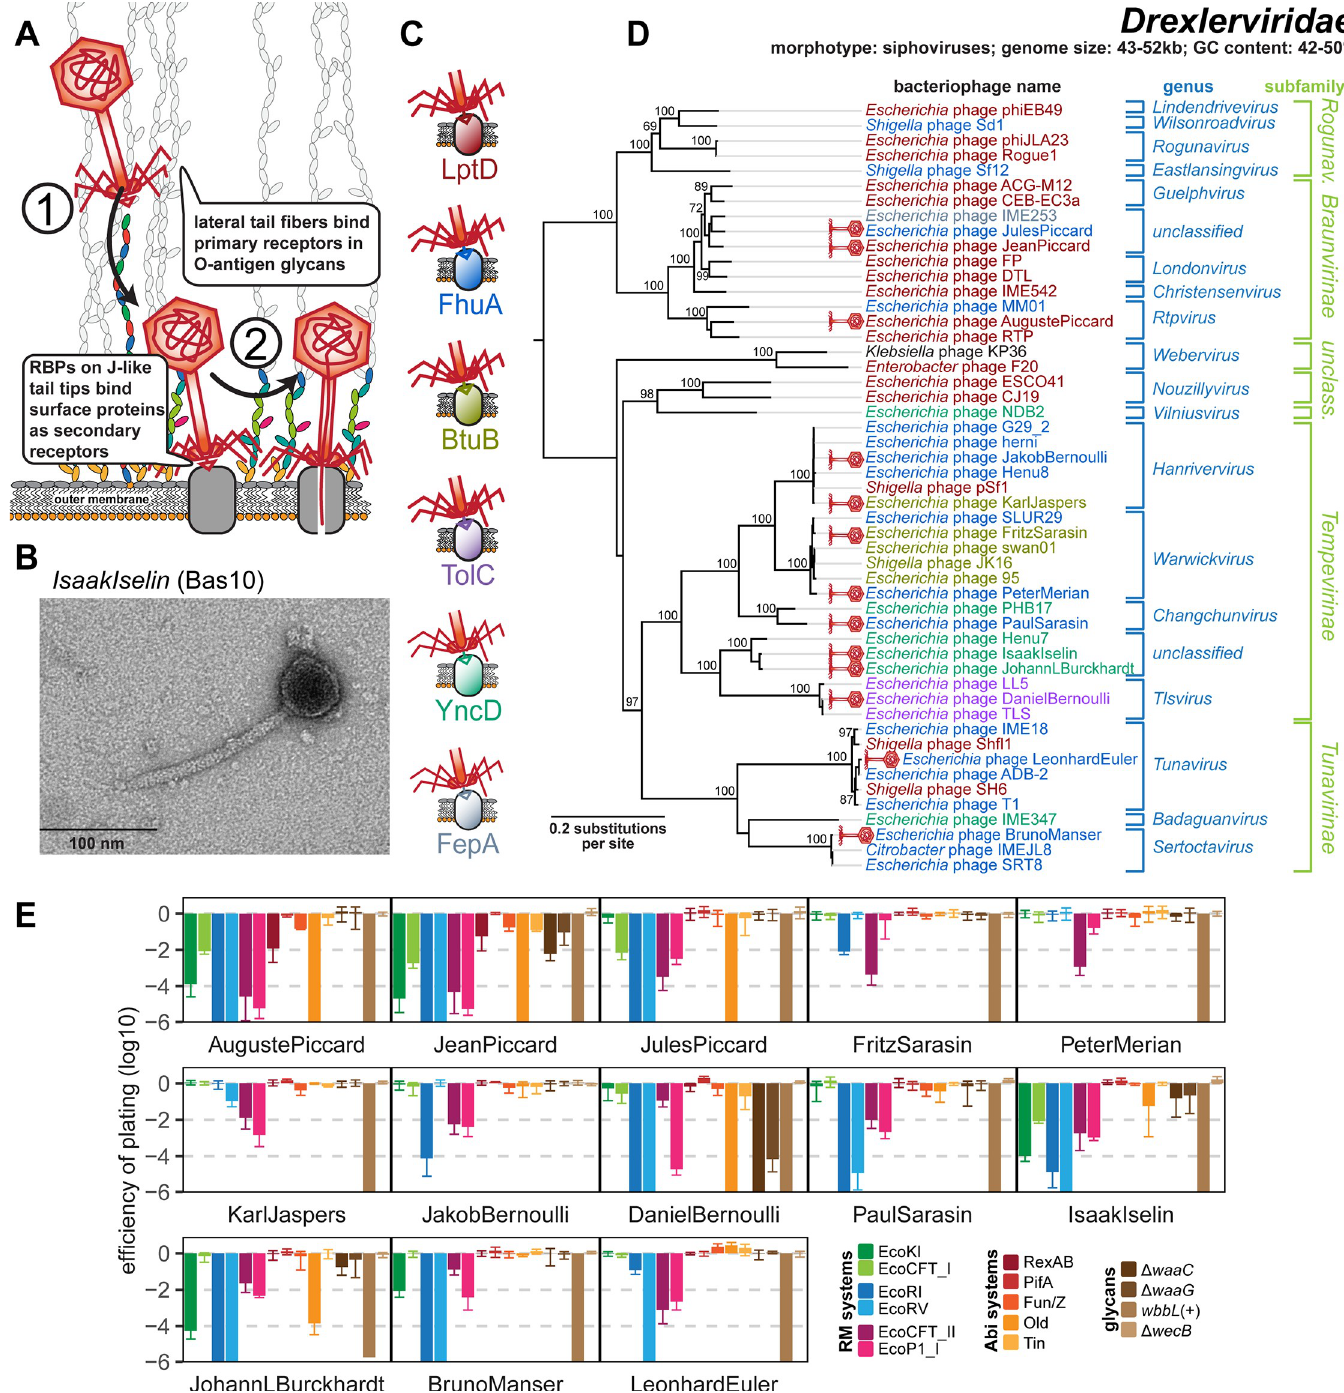
Fig 3. Overview of Drexlerviridae phages. (A) Schematic illustration of host recognition by Drexlerviridae. (B) Representative TEM micrograph of phage IsaakIselin (Bas10). (C) Color code of terminal receptor specificity. (D) Maximum-Likelihood phylogeny of Drexlerviridae based on several core genes with bootstrap support of branches shown if > 70/100. Newly isolated phages of the BASEL collection are highlighted by red phage icons, and the determined or proposed terminal receptor specificity is highlighted at the phage names using the color code highlighted in (C). The phylogeny was rooted based on a representative phylogeny including Dhillonvirus sequences as outgroup (S1A Fig). (E) The results of quantitative phenotyping experiments with Drexlerviridae phages regarding sensitivity to altered surface glycans and bacterial immunity systems are presented as EOP. Data points and error bars represent average and standard deviation of at least 3 independent experiments. Raw data and calculations are available in S1 Data. BASEL, BActeriophage SElection for your Laboratory; EOP, efficiency of plating; RBP, receptor-binding protein; TEM, transmission electron microscopy. https://doi.org/10.1371/journal.pbio.3001424.g003 PLOS Biology | https://doi.org/10.1371/journal.pbio.3001424 November 16,